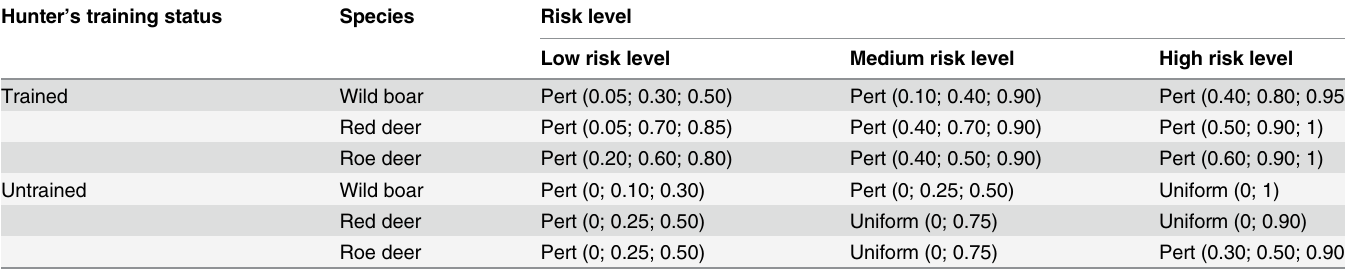
Table 4. Probability of a hunter detecting macroscopic TBLs, by species and awareness of the hunter (training and risk level).